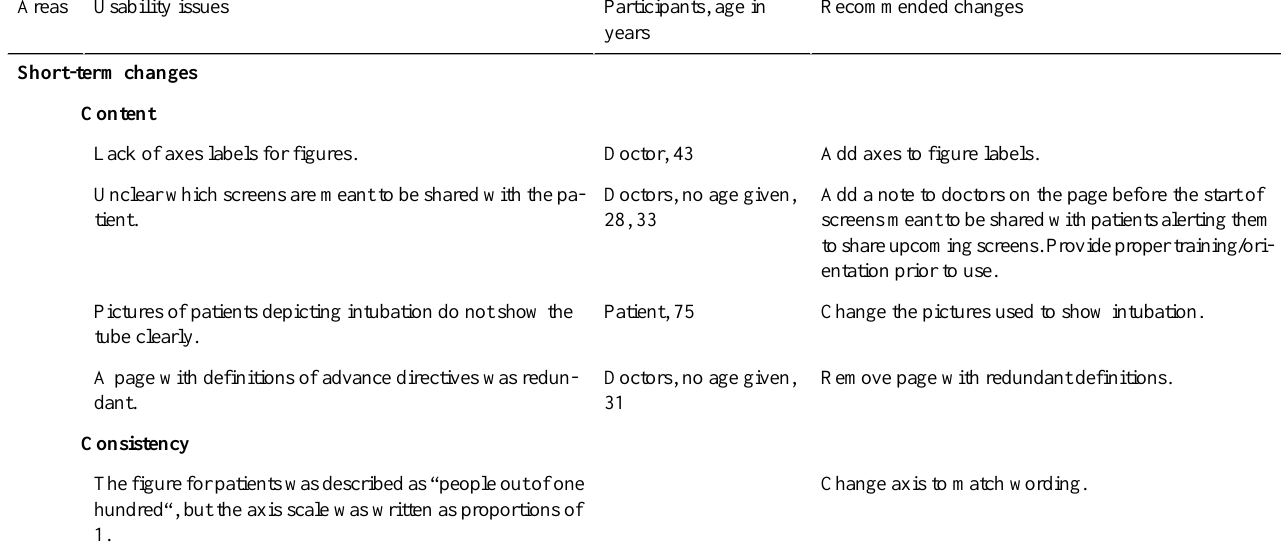
Table 4. Usability issues arising during phase 2 of usability testing and recommended decision aid changes.